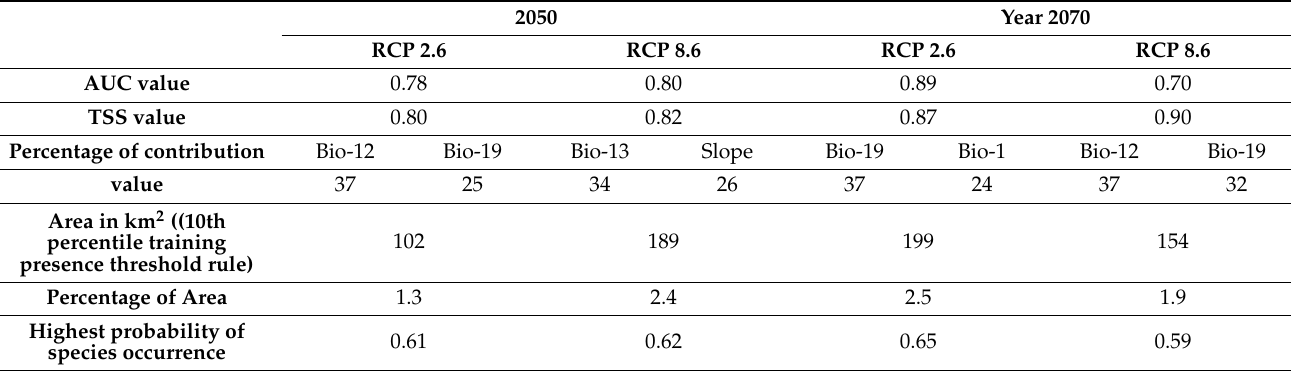
Table 4. Prediction accuracy of C. elegans under future climatic